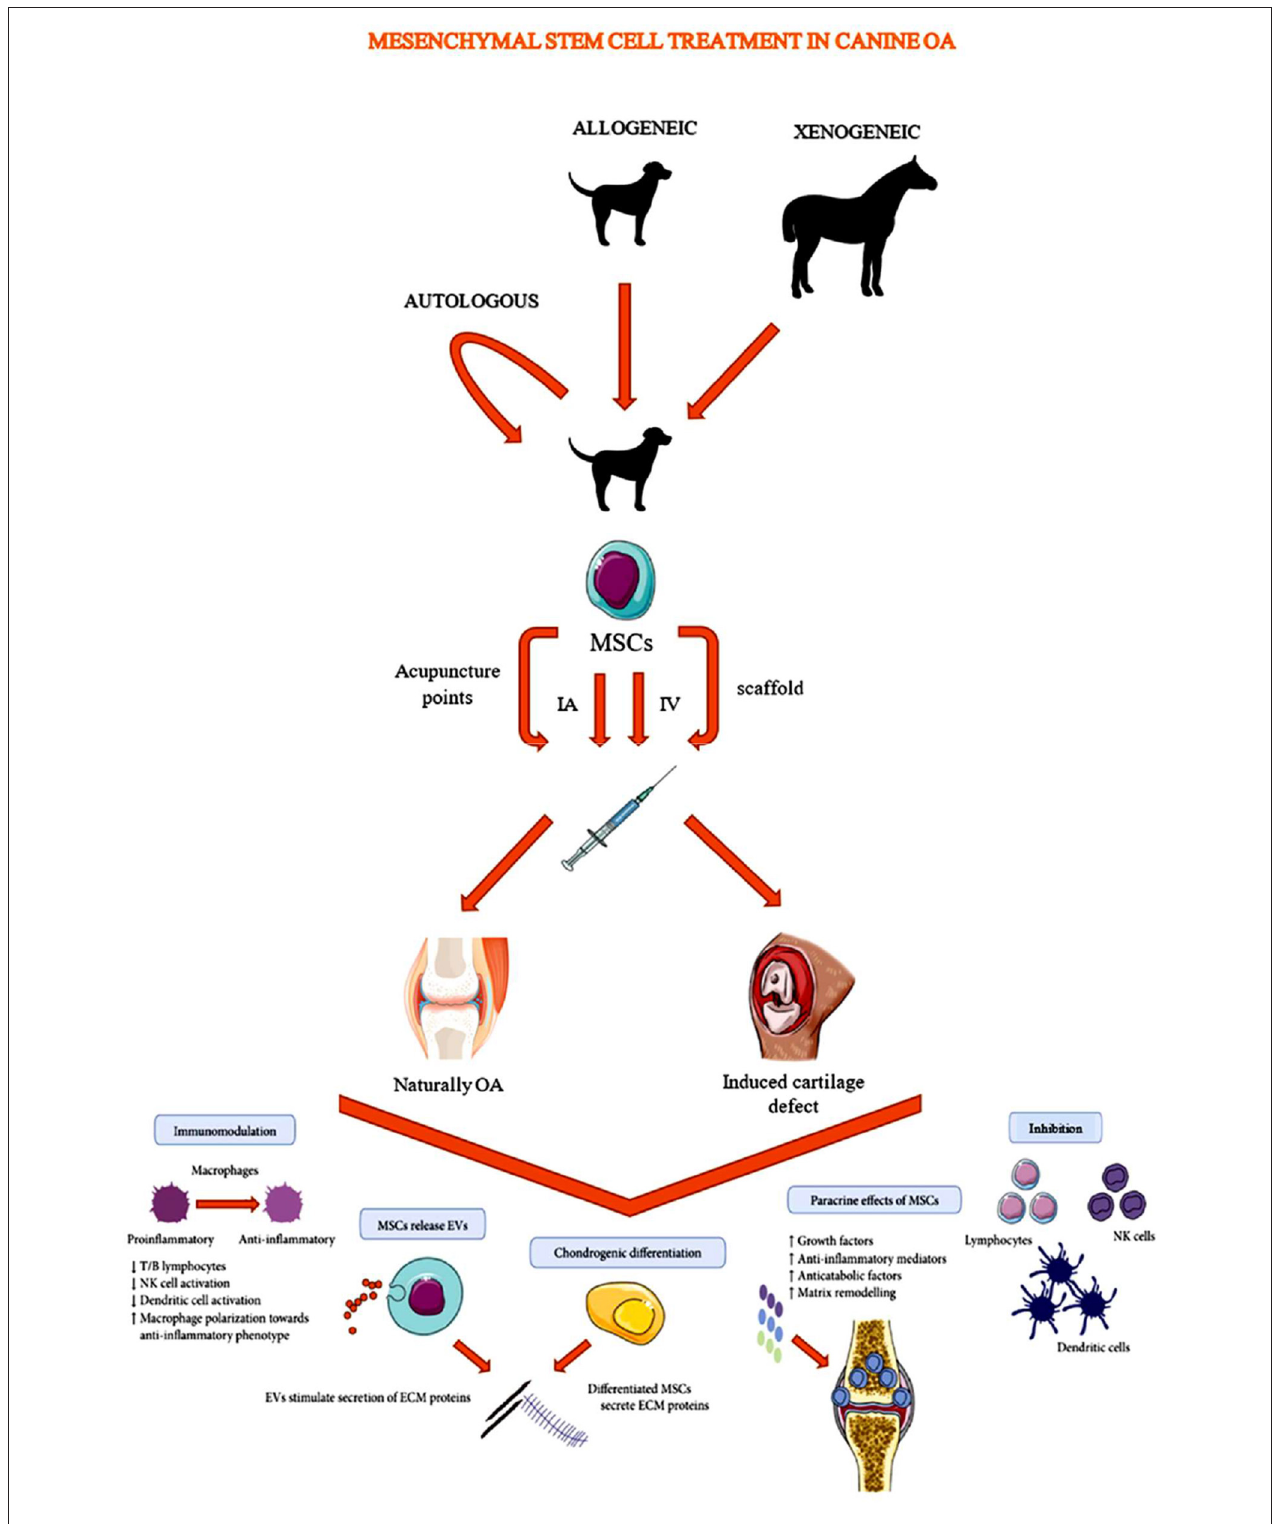
FIGURE 1 | Schematic overview of mesenchymal stem cell administration in canine osteoarthritis studies [Modified from Lo Monaco et al. (20)].